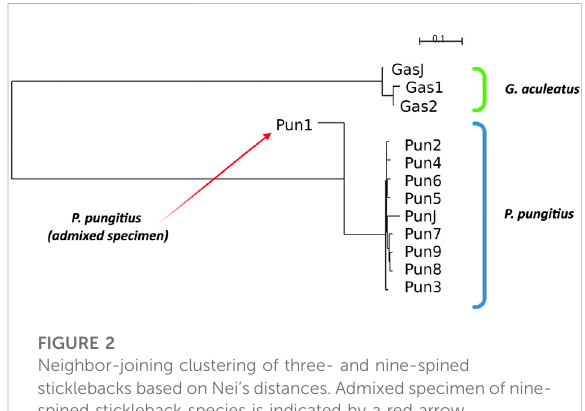
FIGURE 2 Neighbor-joining clustering of three- and